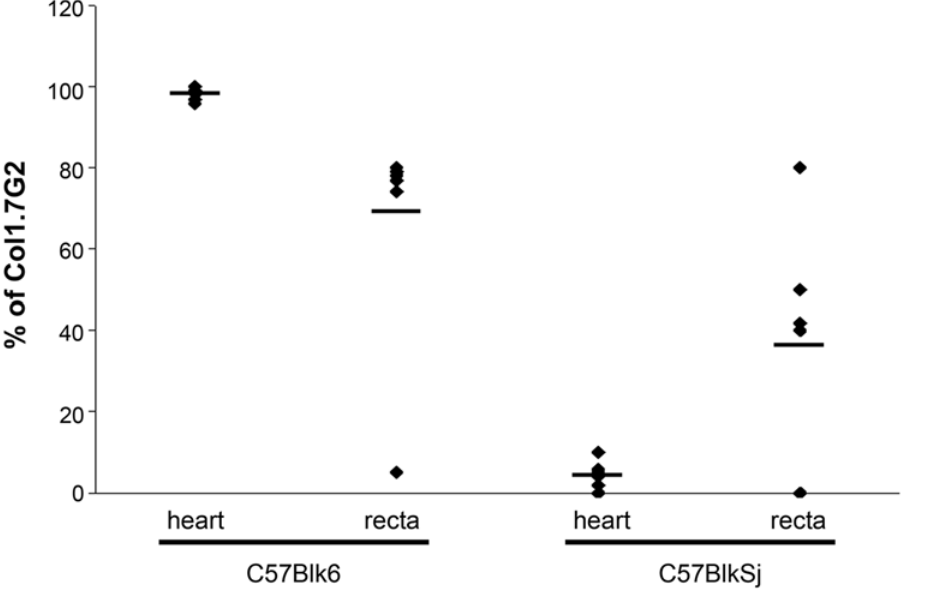
Figure 1. Relative percentage of the Col1.7G2 clone of T.cruzi in tissues of C57Blk6 ( H2 b ) and C57BlkSj ( H2 d ) after six months of double infection with Col1.7G2 and JG strains, using the LSSP-PCR technique. Each point indicates data from individual mice and the bar represents the median value.